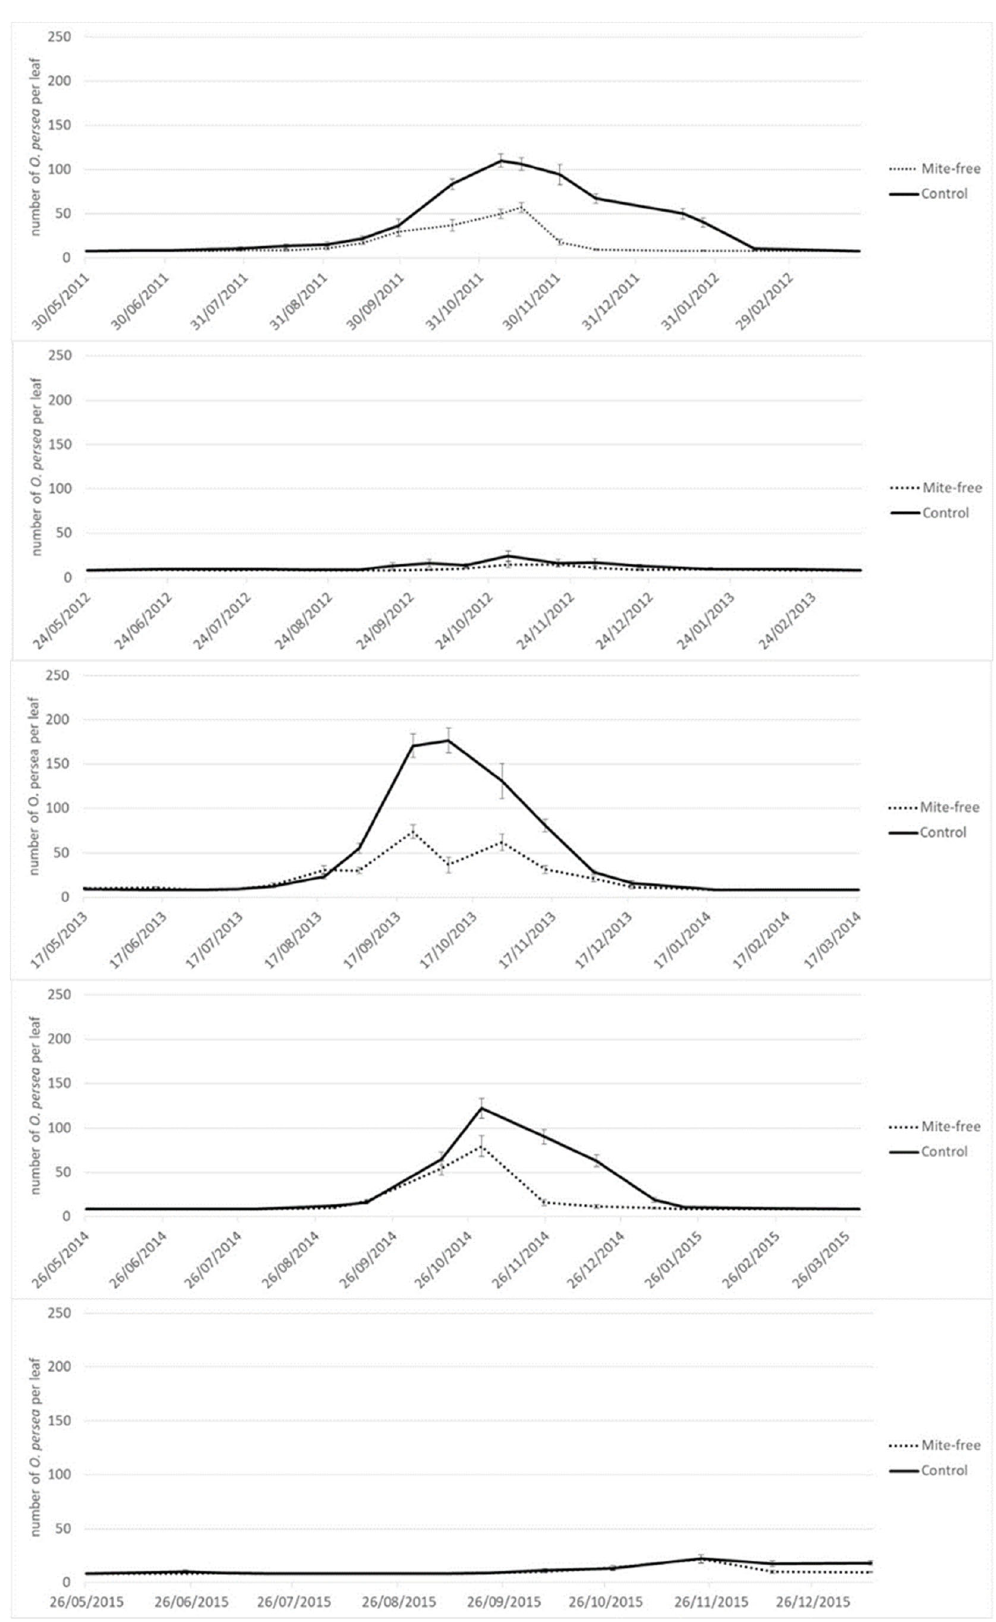
Figure 2. Population dynamics of the Persea mite on avocado trees in Málaga subjected to different treatments from 2011–2015.